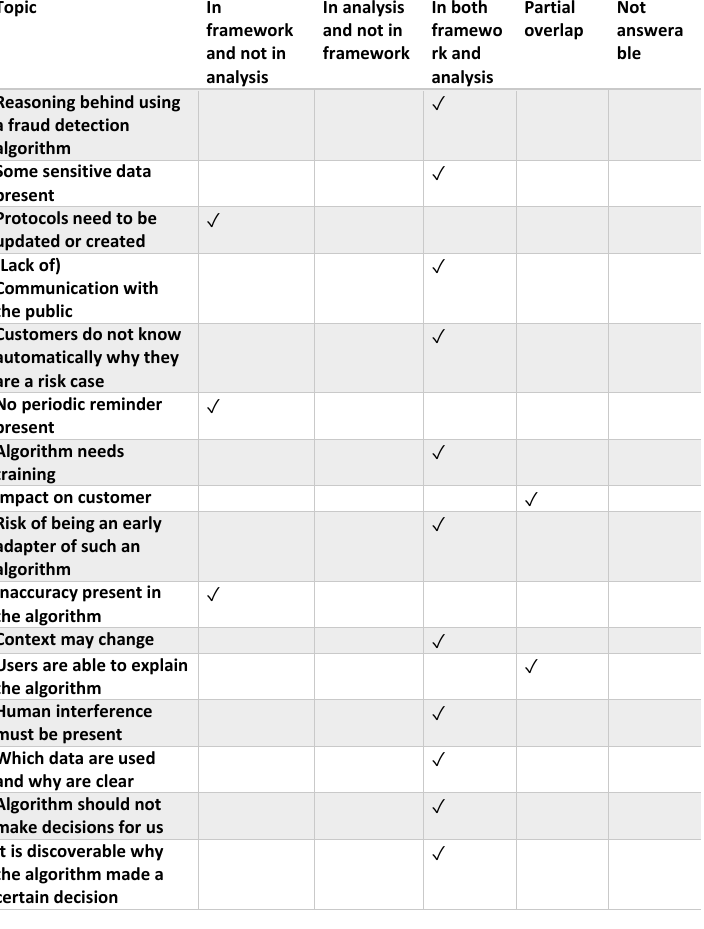
Figure 6. Comparison of specific ethical concerns between framework and the media. Before starting the description of the results of the municipality of Amersfoort, it should be noted that these results are not precisely comparable to SyRI. This is mainly because 19 more questions were answerable as there were people involved with inside information. It is not reasonable to assume that these 19 questions would all have been answered positively or negatively for SyRI. Another difference is that the SyRI algorithm was already in use, whereas the algorithm from the municipality of Amersfoort is still in the development phase. This means that some aspects simply have not been arranged yet, because they were planned for a later stage. This means that some questions are marked red or orange in the framework, which will turn green when re-evaluated